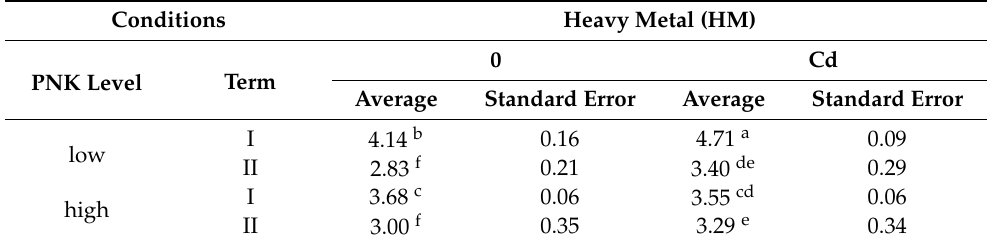
Table 7. The content of dissolved oxygen in water (mg · dm − 3 ) in the three tested growing seasons. Conditions